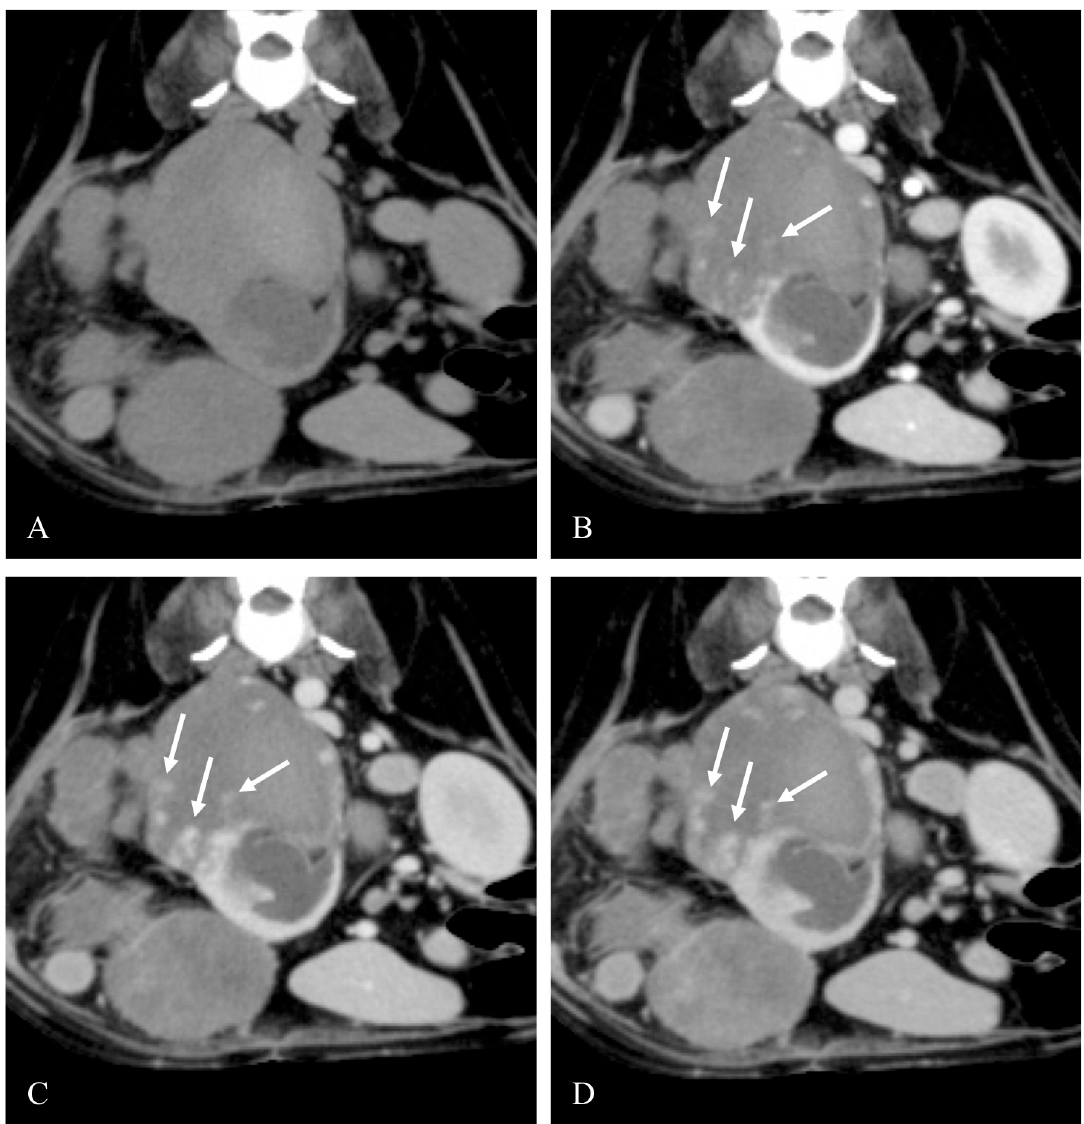
Fig 3. Representative axial pre-contrast (A) CT image of an HSA and post-contrast corticomedullary (B), nephrographic (C), and excretory (D) phase CT images of the HSA. The tumor had unilateral involvement and showed heterogeneous enhancement. Vessel enhancement was detected in all of the post-contrast images. The enhanced area of the tumor gradually expanded around the vessel (arrow). Abbreviations: CT, computed tomography; HSA, hemangiosarcoma.